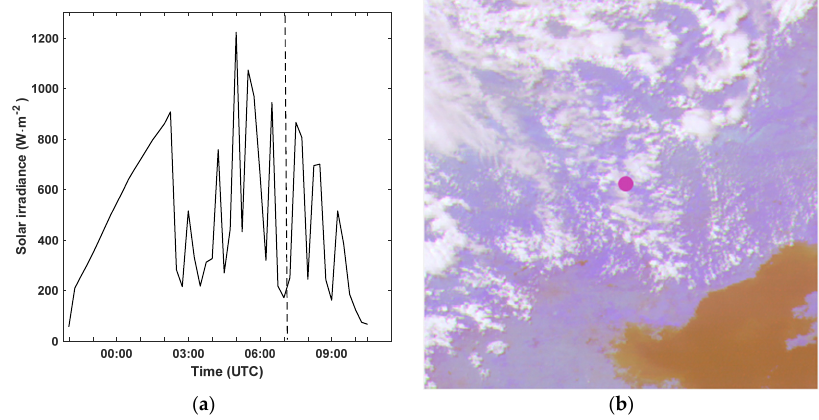
Figure 1. Example of variation curve of the global horizontal irradiance (GHI) measurement at meteorological station in Chengde on 1 July 2019 ( a ) and time-matched FY-4A satellite images on 1 July, 2019 at 07:15 UTC ( b ). The red point is the location of the ground observation station.